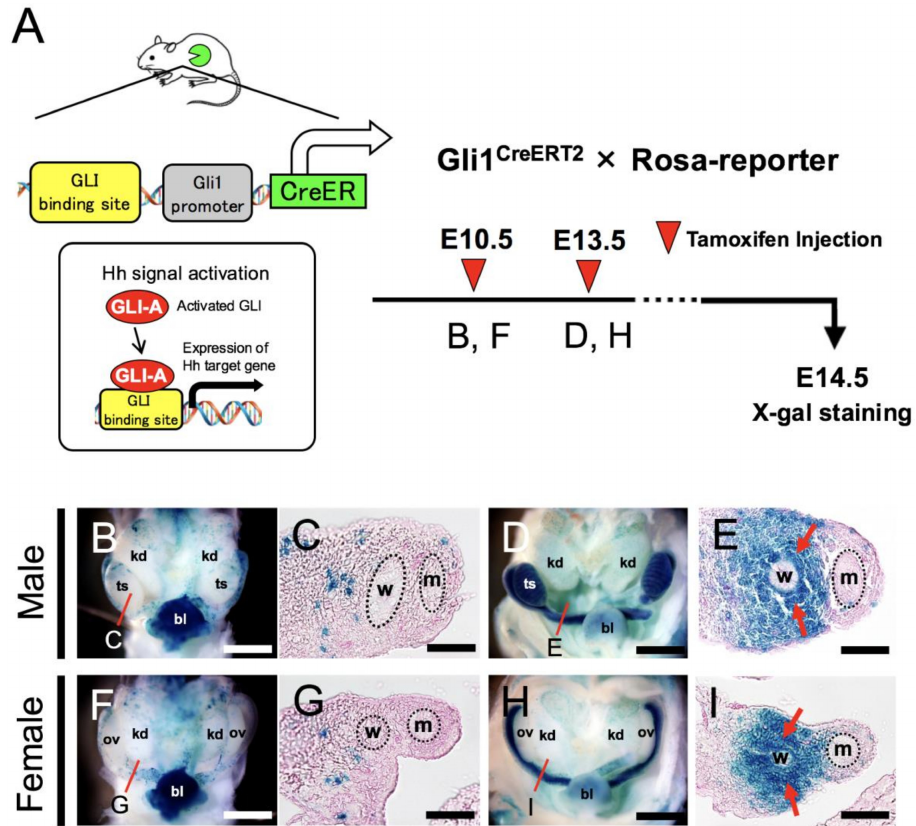
Figure 3. Gli1 CreERT2 allele marks Hh-signal-responsive cells in the Wolffian region. ( A ) The left panel shows a schema of the transcriptional machinery of the Gli1 CreERT2 allele. In the Hedgehog (Hh) pathway-activated cells, the Gli1 CreERT2 allele expresses a tamoxifen (TM) inducible Cre recombinase inserted into the Gli1 locus, a Hh direct target gene. The right panel shows the experimental schedule for TM administration used in ( B – I ) to analyze the contribution of Hh-signal-responsive cells to the reproductive tissue formation during the embryonic stage. ( B – I ) Whole-mount and section images of X-gal- stained Gli1 CreERT2 ; Rosa26 -LacZ specimens at E14.5. Red lines in ( B , D , F , H ) indicate sites of transverse sections in ( C , G , E , I ). In both male and female embryos administered TM at E13.5, β -galactosidase activity showing Hh-signal-responsiveness (red arrows) is detectable in the mesenchymal cells surrounding the WD ( E , I ). Compared with E13.5 labeling, X-gal-stained cells in E10.5 TM injected embryos are sparsely scattered in the Wolffian tissues ( C , G ). These results were observed in several individuals ( n = 3). bl, bladder; kd, kidney; md, Mullerian duct; ov, ovary; ts, testis; w, Wolffian duct. Scale bars indicate 200 µ m ( B , F , D , H ) and 50 µ m ( C , E , G , I